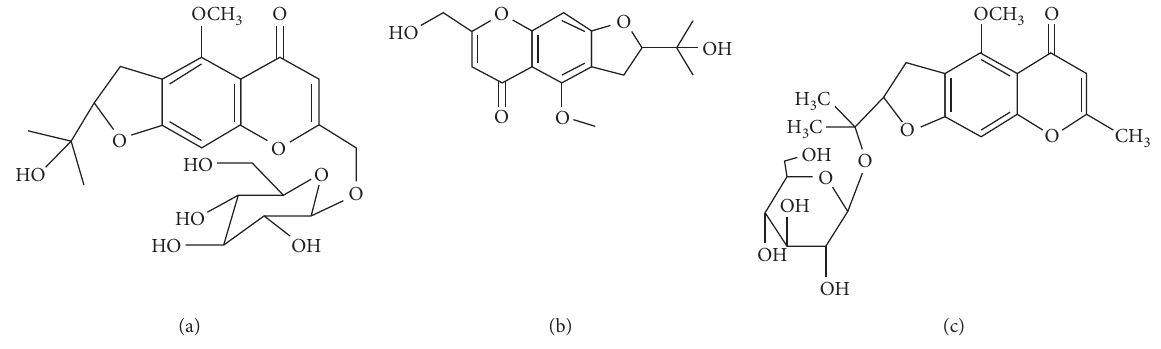
Figure 1: Chemical structure of chromones in SR: (a) POG; (b) CIM; (c) Table 1: The types of prepared DES.